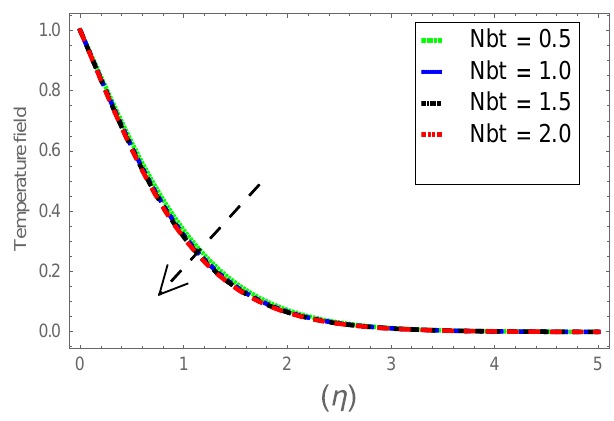
Figure 26. Consequence of